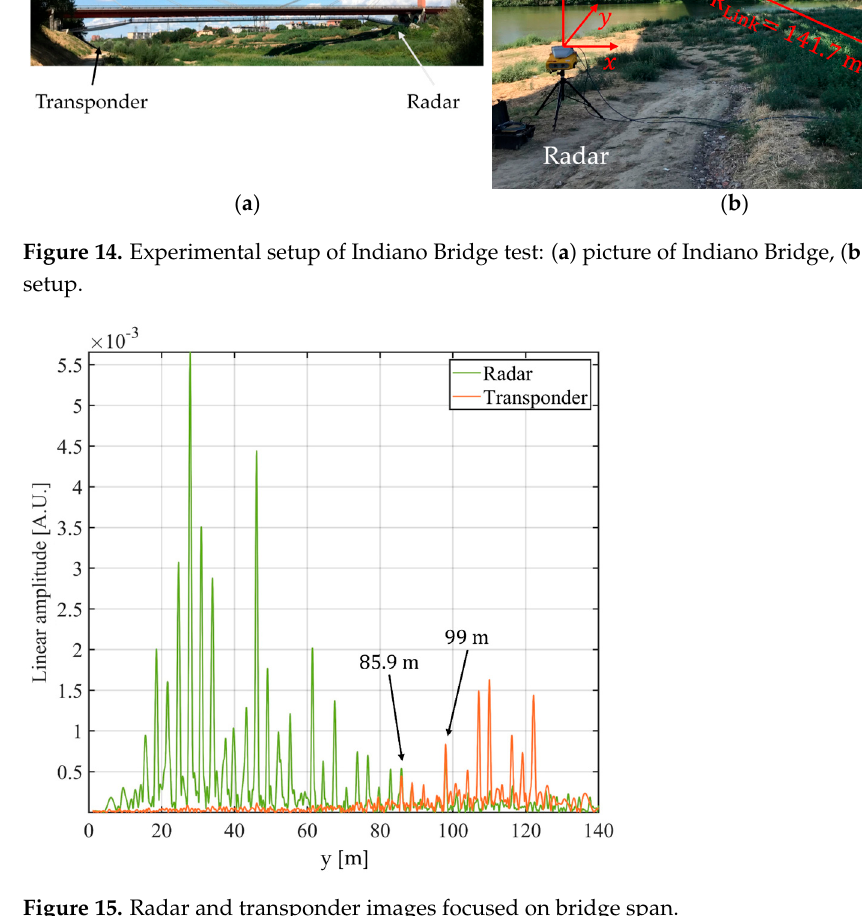
Figure 15. Radar and transponder images focused on bridge span.